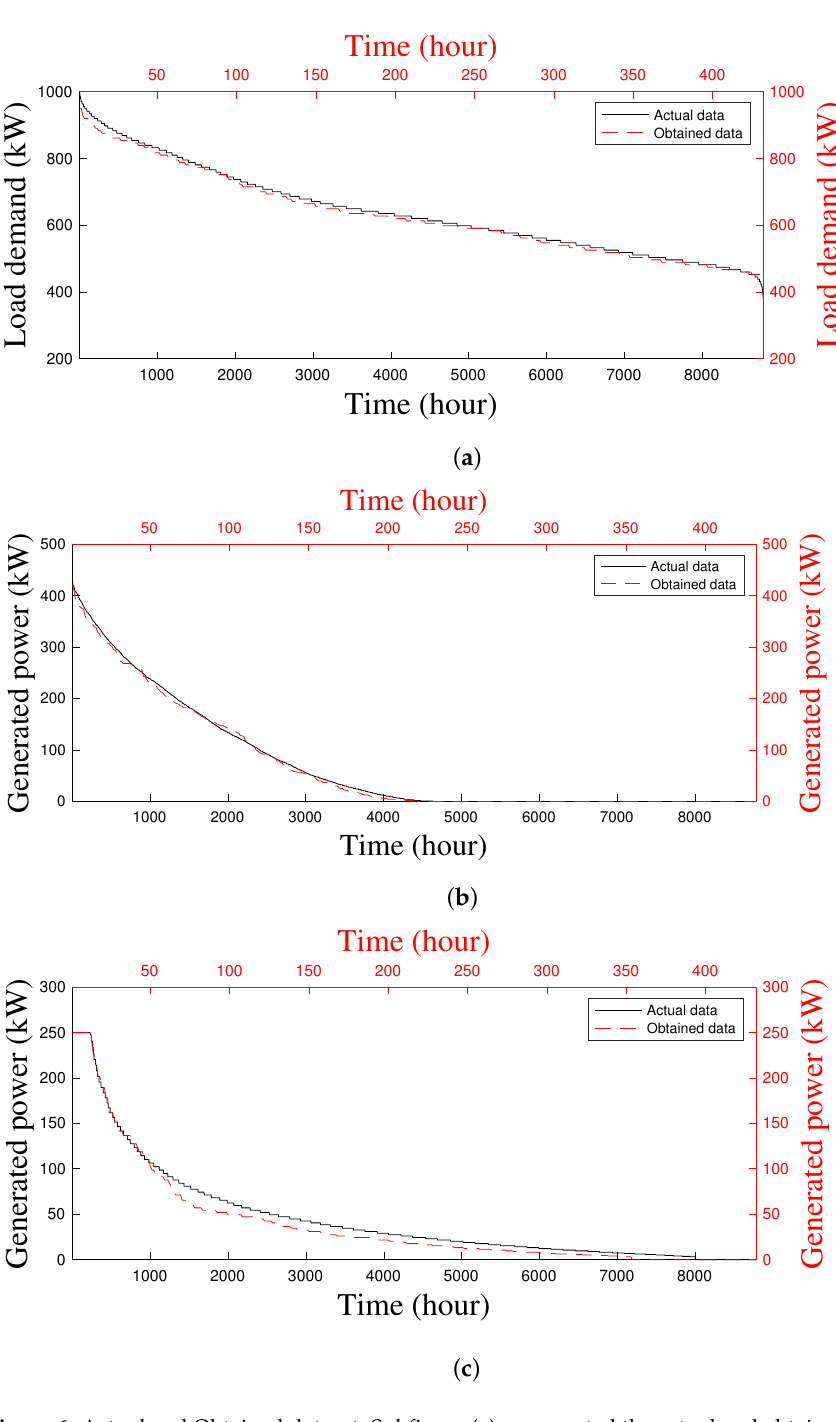
Figure 6. Actual and Obtained dataset. Subfigure ( a ) represented the actual and obtained load profile by clustering. Subfigure ( b ) represented the actual and obtained PV power generation by clustering. Subfigure ( c ) represented the actual and obtained WG power generation by